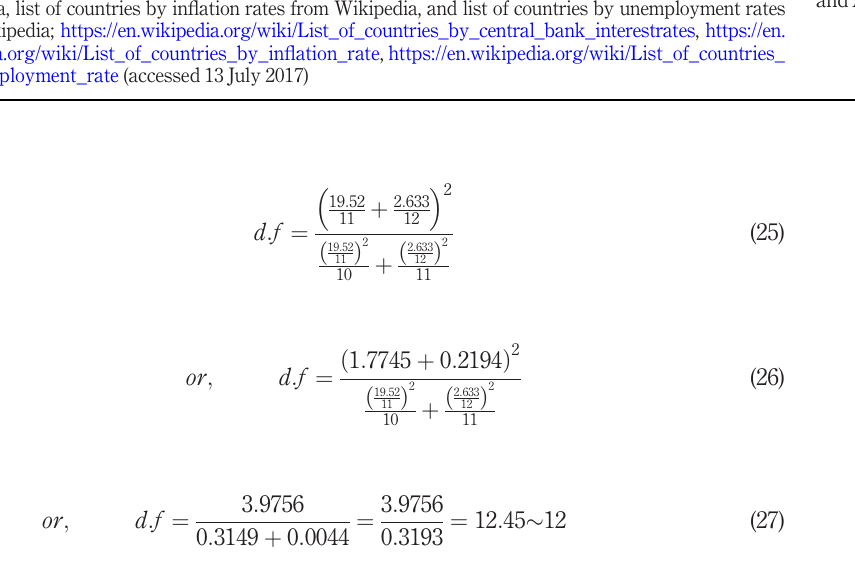
Table II. Statistical test of mean differences in MI in Group X and Group Y countries _ where P is in fl